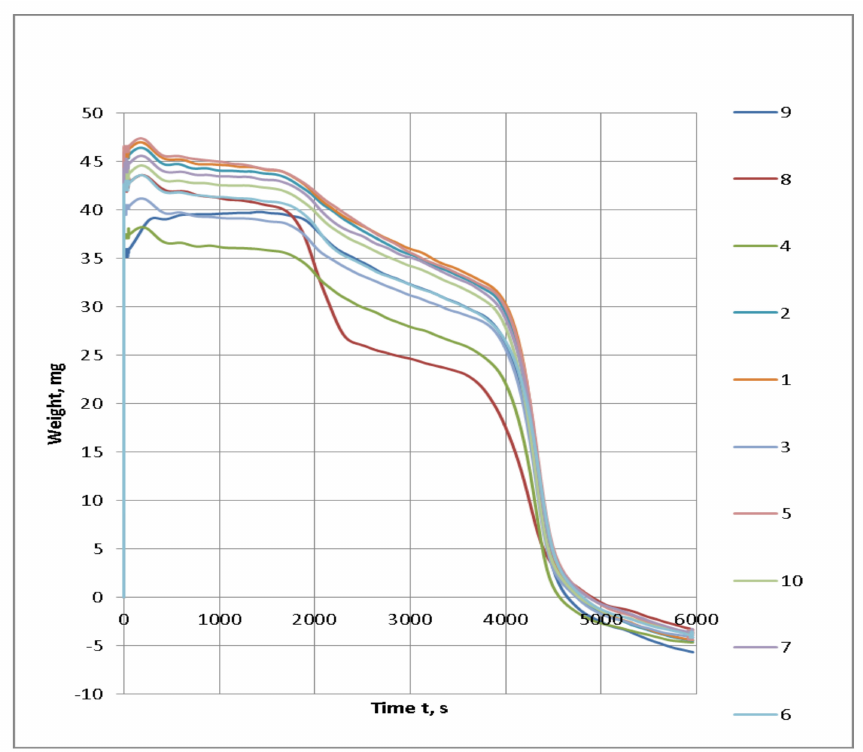
Figure 4. TG thermograms of the tested PFA samples of the di ff erent brands.